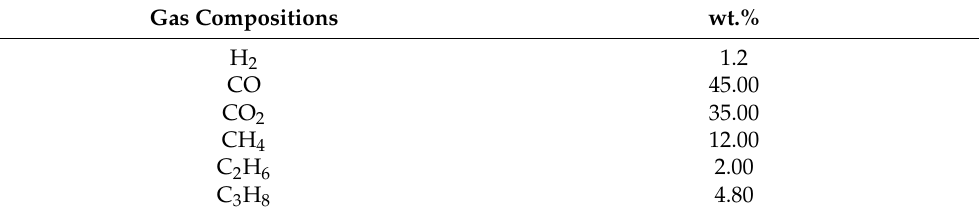
Table 4. Pyrolysis gas composition used in the simulation.